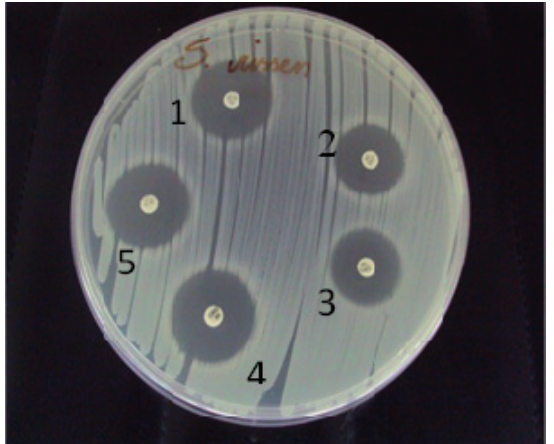
Figure 1. Initial screening for extended-spectrum beta-lactamase production by the disk diffusion method. Antibiotic disks (30 μ g each): 1, aztreonam; 2, ceftazidime; 3, cefoxitin; 4, ceftriaxone, and 5,